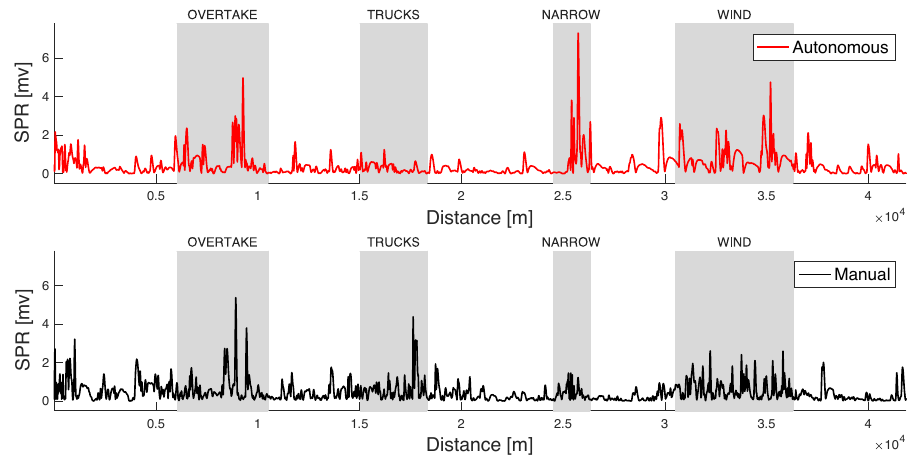
Figure 8. SPR signal of a different test subject, in both manual and autonomous scenarios (local RMS